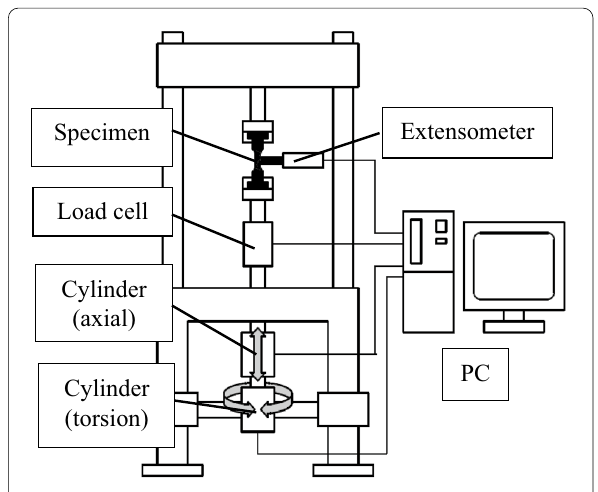
Figure 2 Schematic view of the fatigue testing machine